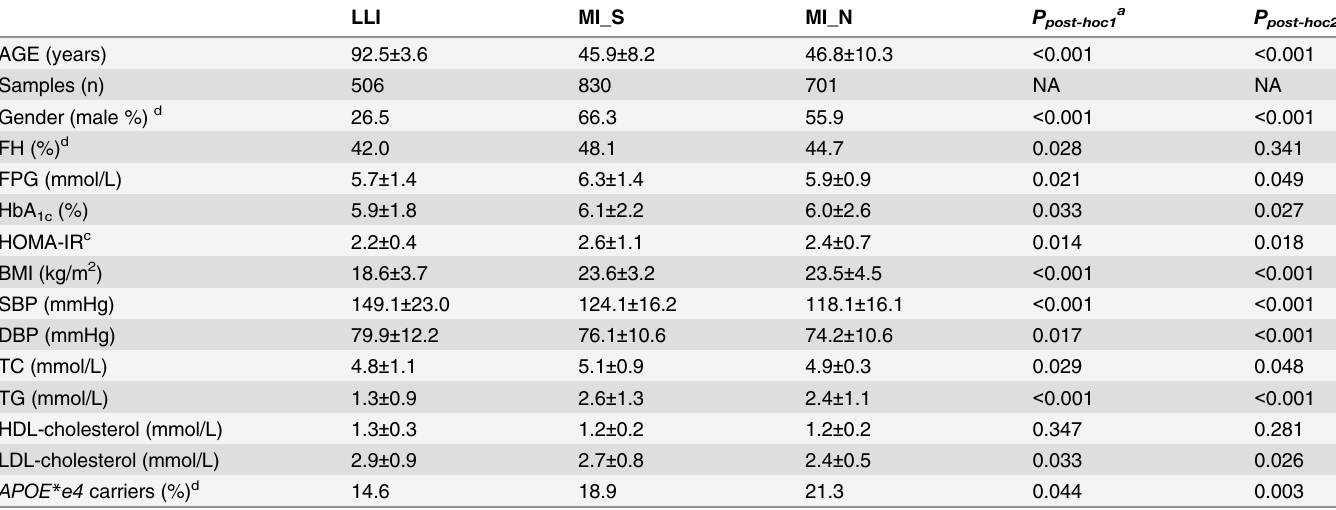
Data are shown as the mean ± SD or n; FH: fasting hyperglycemia; LLI: long-lived individuals; MI_S: middle-aged controls (southern); MI_N: middle-aged (northern); HbA 1c : hemoglobin A 1c ; HOMA-IR: homeostasis model assessment of insulin resistance; BMI: body mass index; SBP: systolic blood pressure; DBP: diastolic blood pressure; TC: total cholesterol; TG: triglyceride; HDL: high density lipoprotein; LDL: low density lipoprotein; NA: not available. a p values of post-hoc pair-wise comparisons of the parameters between LLI and MI_S. b p values of post-hoc pair-wise comparisons of the parameters between LLI and MI_N. c after log-transformed to normalize skewed distribution. d comparison of categorical variable based on Chi-square test.